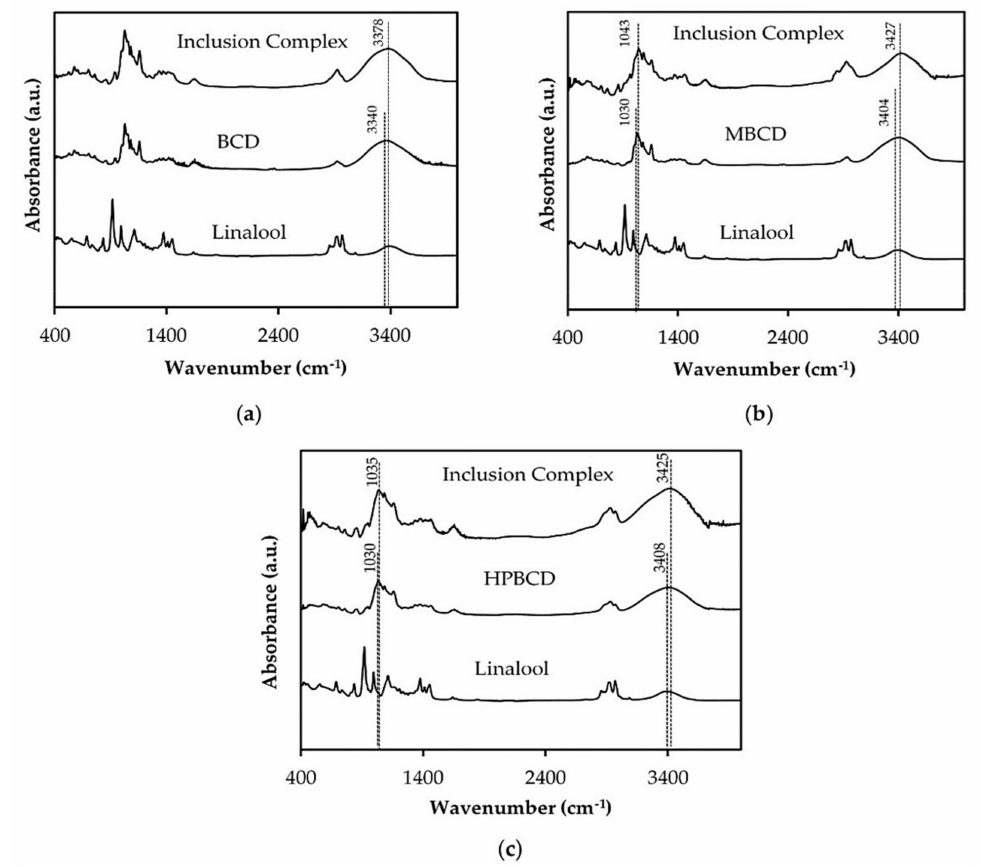
Figure 14. The FTIR spectra of ( a ) linalool/BCD inclusion complex, BCD, and linalool, ( b ) linalool/MBCD inclusion complex, MBCD, and linalool, and ( c ) linalool/HPBCD inclusion complex, HPBCD, and